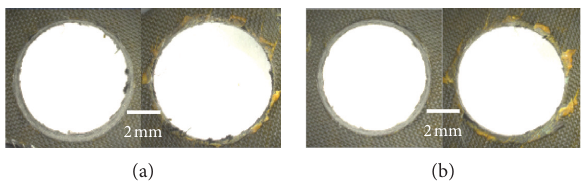
Figure 18: Outlet quality comparison. (a) Original sets. (b) Improved sets.